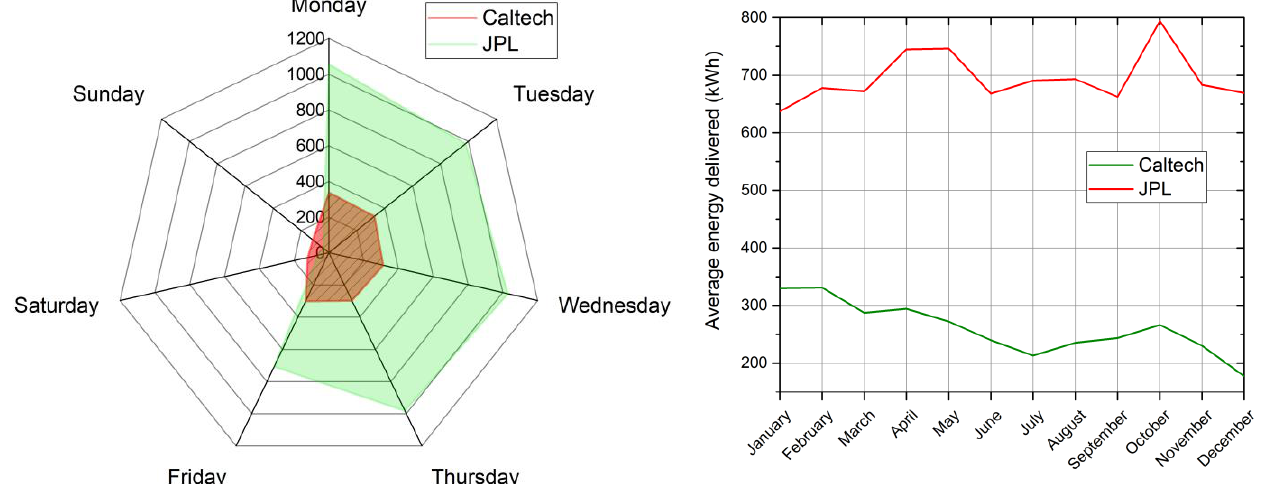
Figure 3. Average power demand of different days and months.